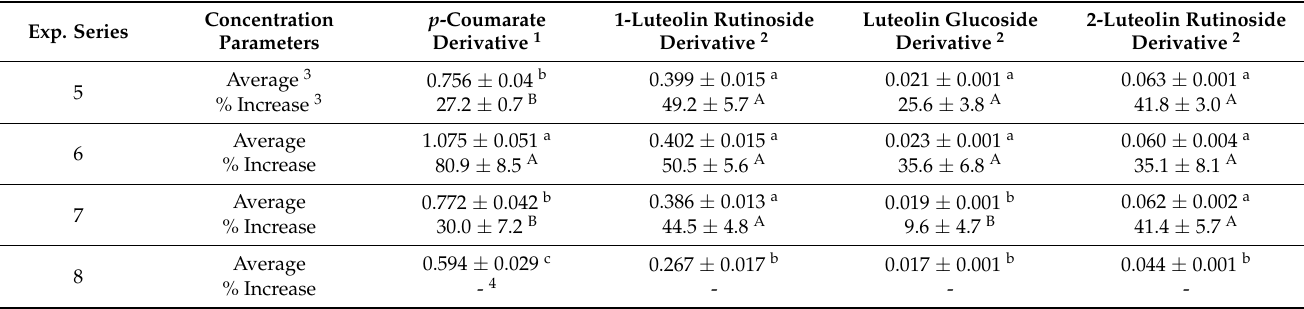
Table 3. Elaeagnus leaves were extracted for 20 min with 0% EtOH, yielding a concentration of the major compounds (mg g − 1